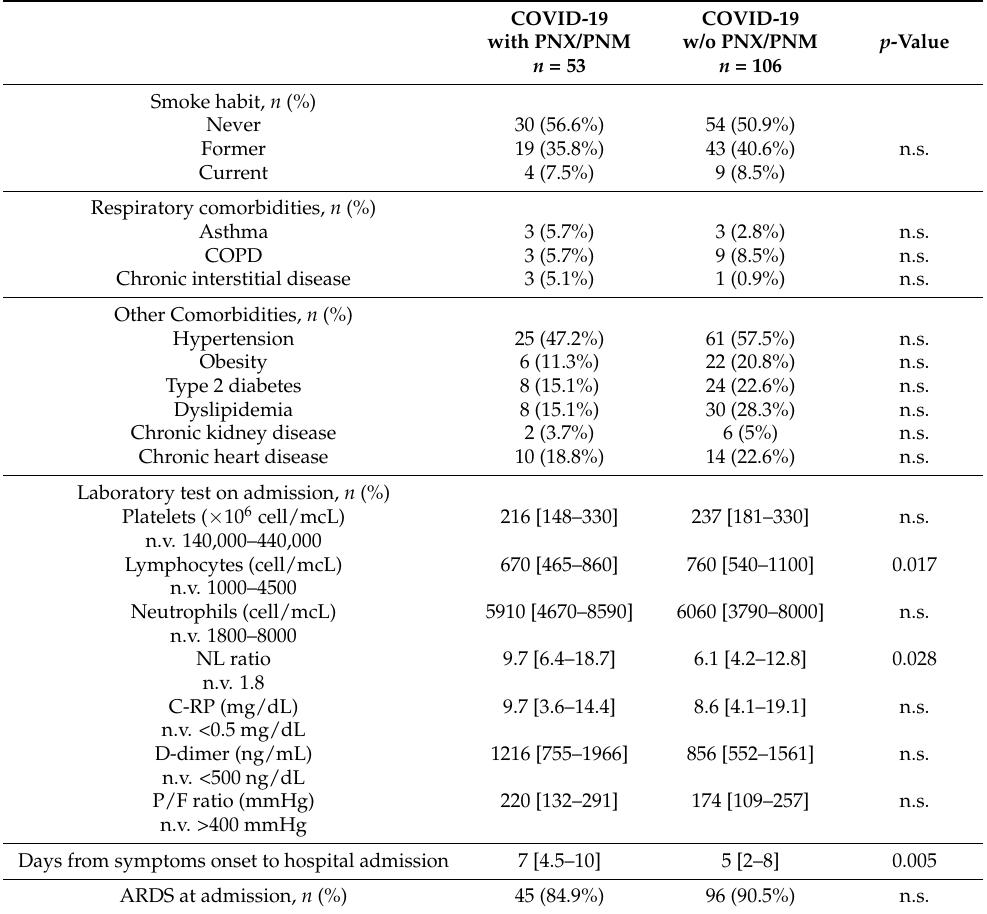
Table 2. Past medical history and admission characteristics of COVID-19 patients with and without PNX/PNM.